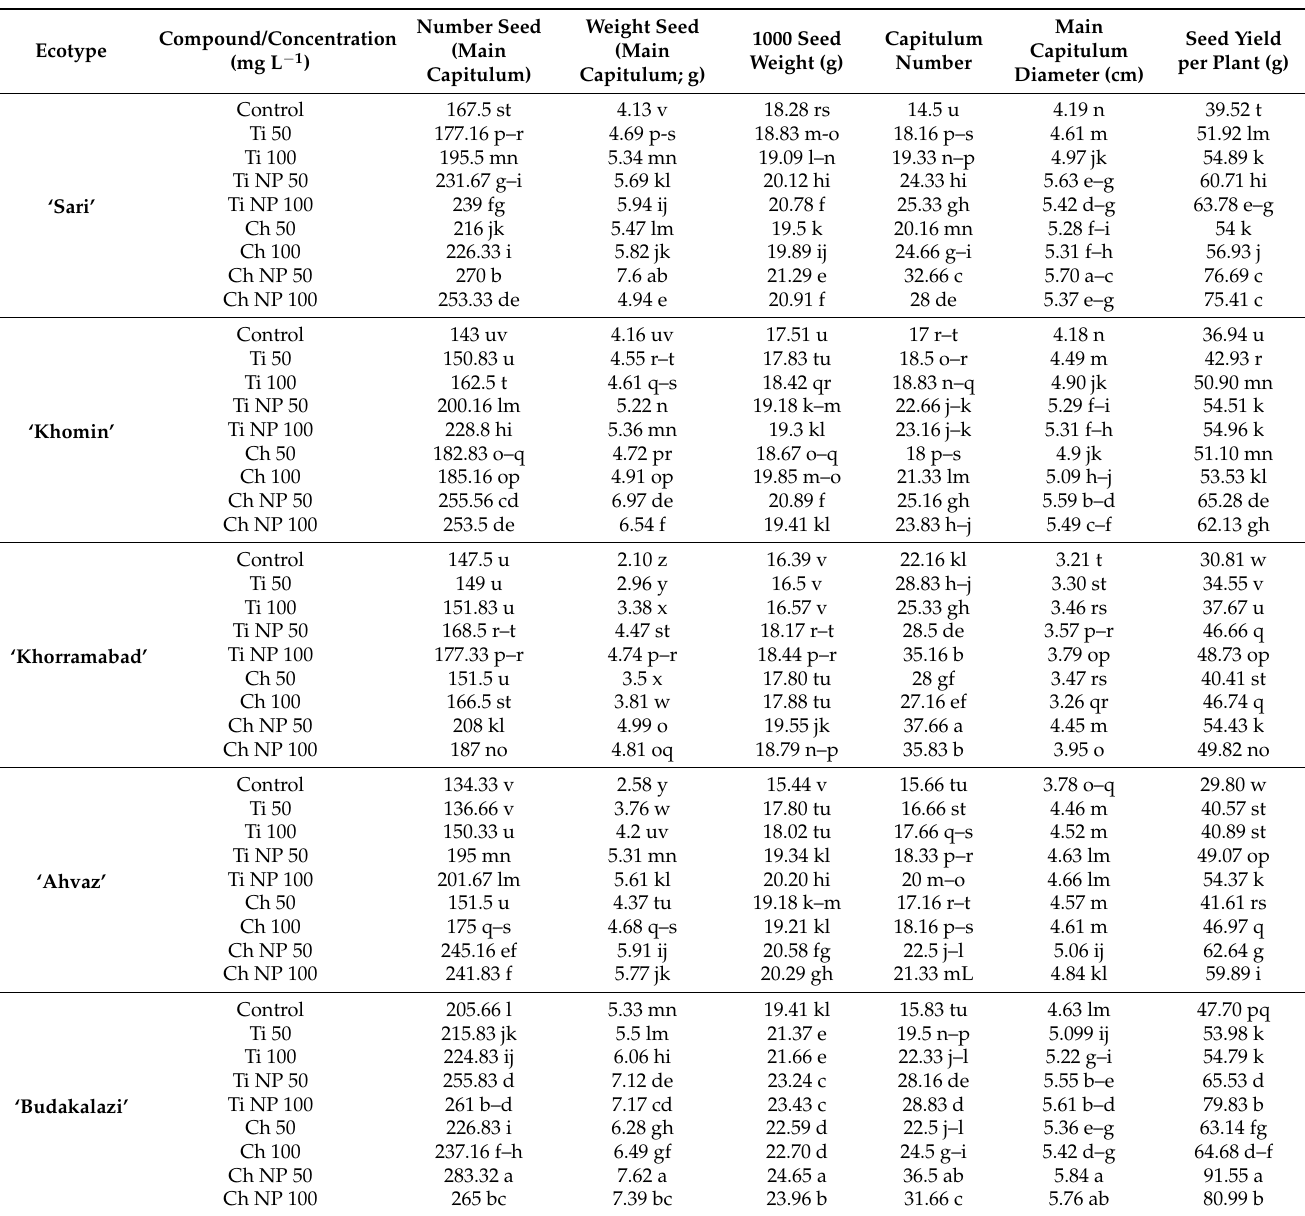
Table 5. Effects of chitosan and titanium dioxide (denoted as Ch and Ti, respectively) treatments [bulk, nanoparticle (NP)] applied at three concentrations (0, 50, and 100 mg L − 1 ) on seed yield-related parameters of five milk thistle ecotypes. Three plants per treatment were assessed. Different letters within a column indicate statistically significant differences ( p <